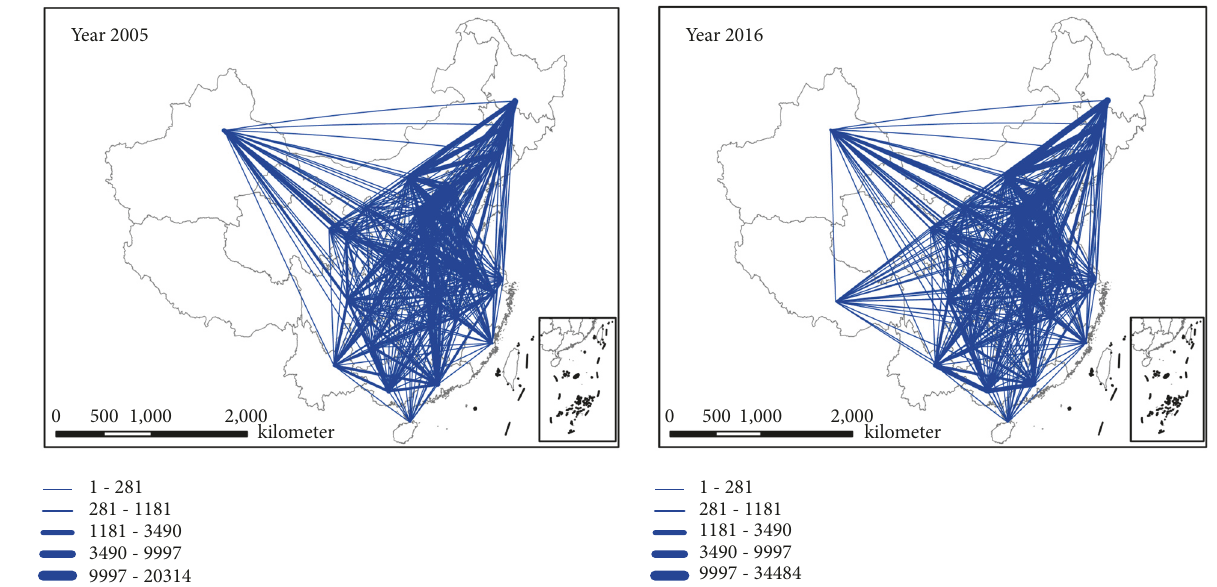
Figure 1: China's RFTN in 2005 and 2016; the legend represents the freight volumes (weights).